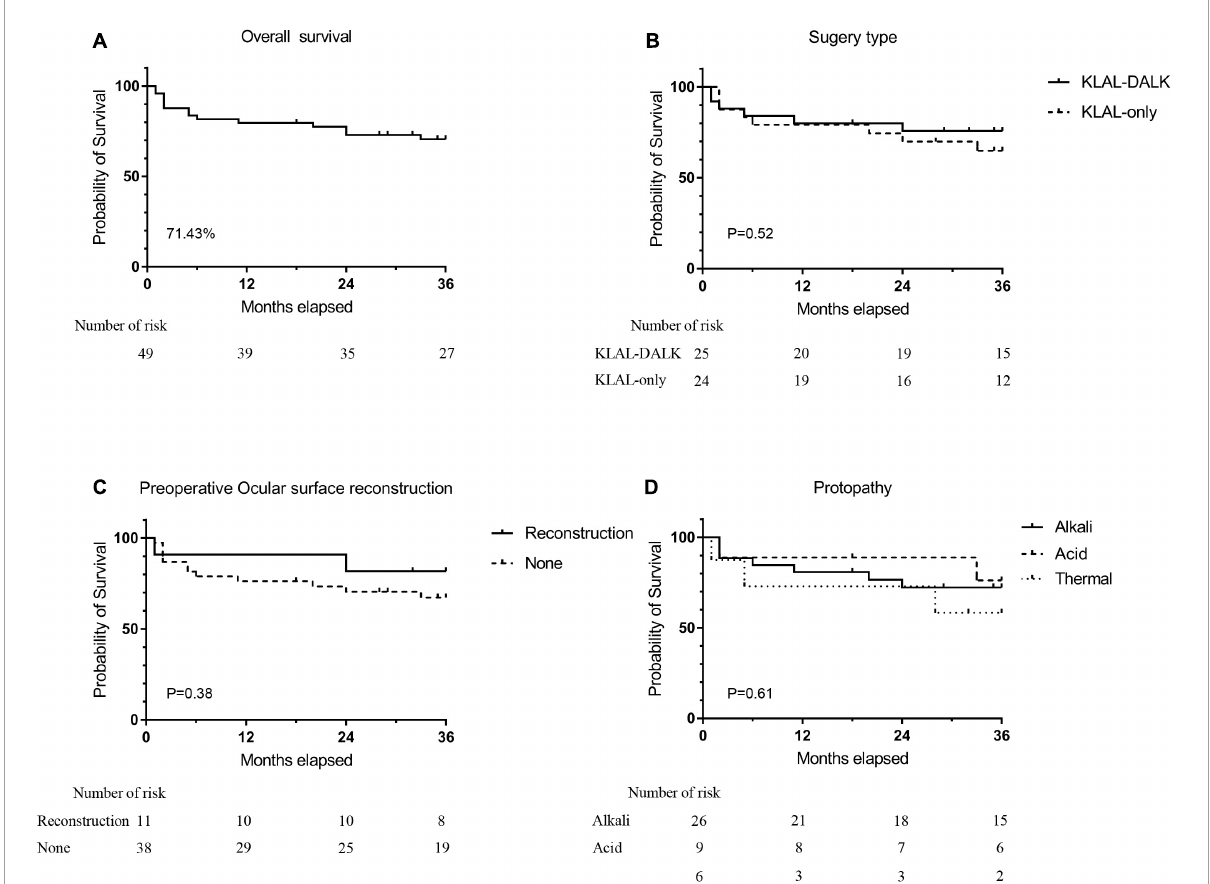
FIGURE2 Kaplan–Meier survival analysis of graft survival with a stable corneal surface after KLAL transplantation. Survival analysis of grafts for all treated eyes ( n = 14). Three years after surgery, 71.43% of eyes had a stable and improved corneal surface (A) . Grafts in eyes that underwent KLAL transplantation only ( n = 24) had a similar survival curve as grafts in eyes that underwent KLAL transplantation with DALK ( n = 25). Three years after surgery, the corneal surface was stable in 66.7% of eyes in the KLAL-only group and 76% of eyes in the KLAL-DALK group (B) . Survival analysis of grafts on the basis of preoperative etiology (C) , whether ocular surface reconstruction (D) was performed before KLAL transplantation, which showed no significant difference (log-rank test, P > 0.05). KLAL, keratolimbal allograft; DALK, deep anterior lamellar keratoplasty; LSCD, limbal stem cell